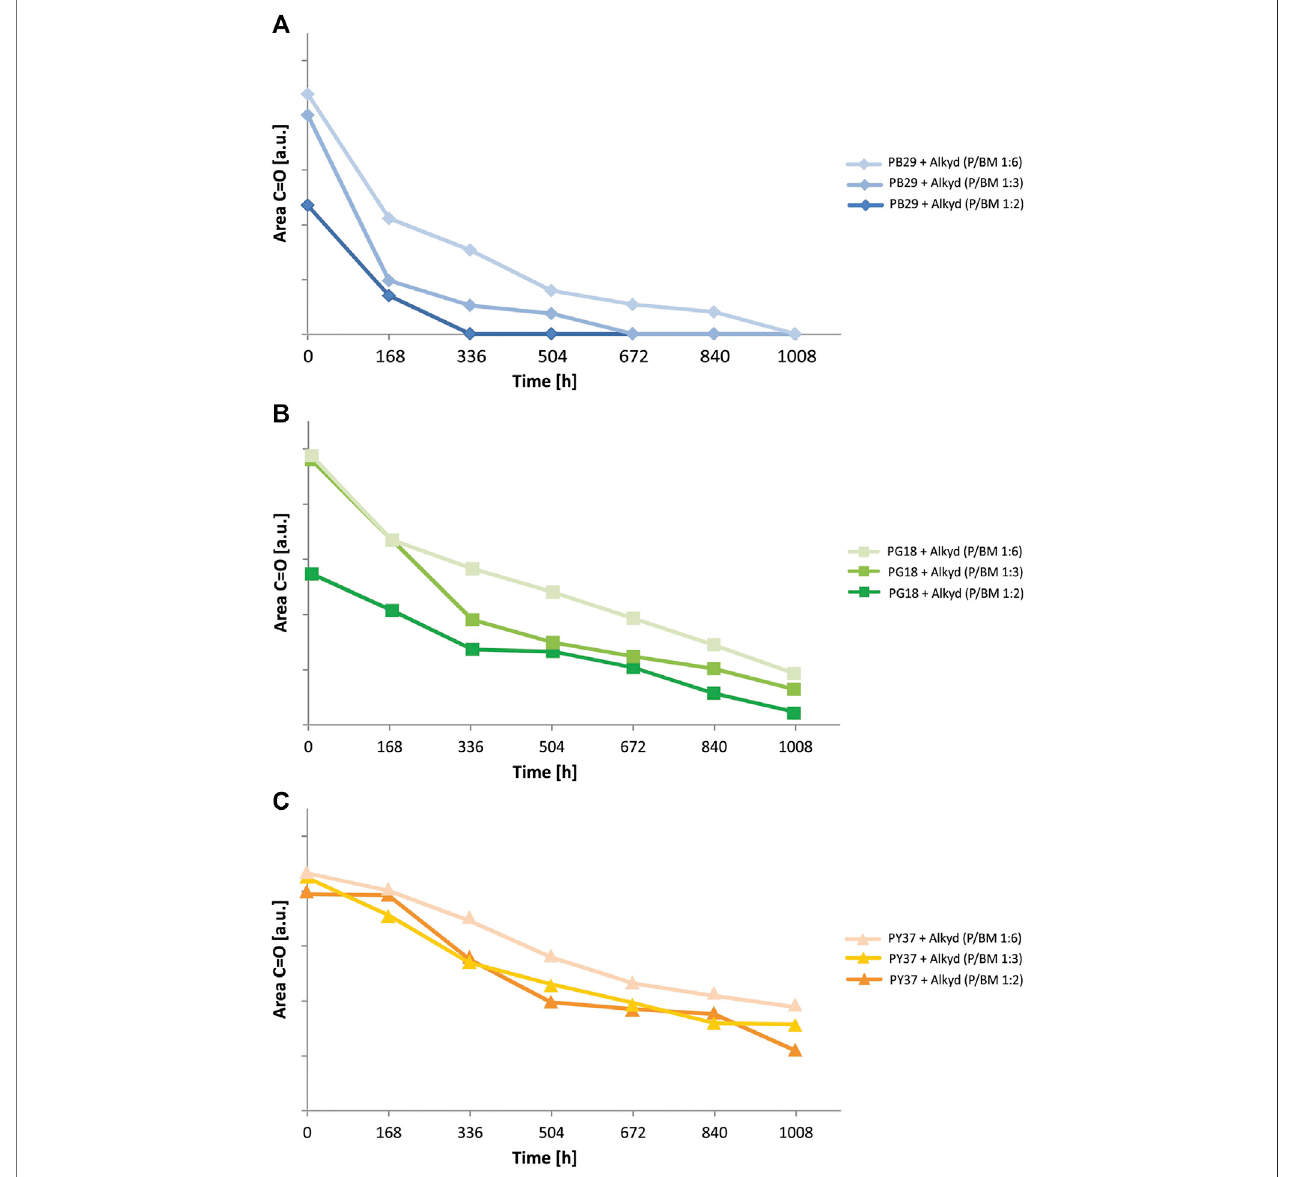
FIGURE 7 | Photodegradation kinetics observed from ATR-FTIR spectra of alkyd paints with (A) PB29, (B) PG18, and (C) PY37, at various P/BM ratios.